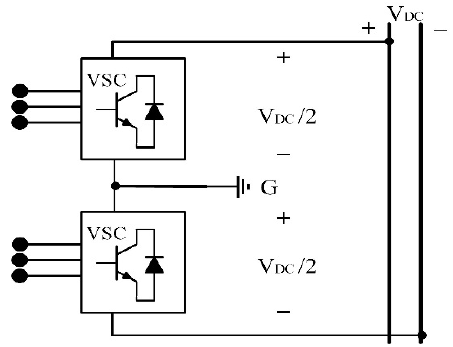
Figure 10. Solid Grounding at the mid-point [60].